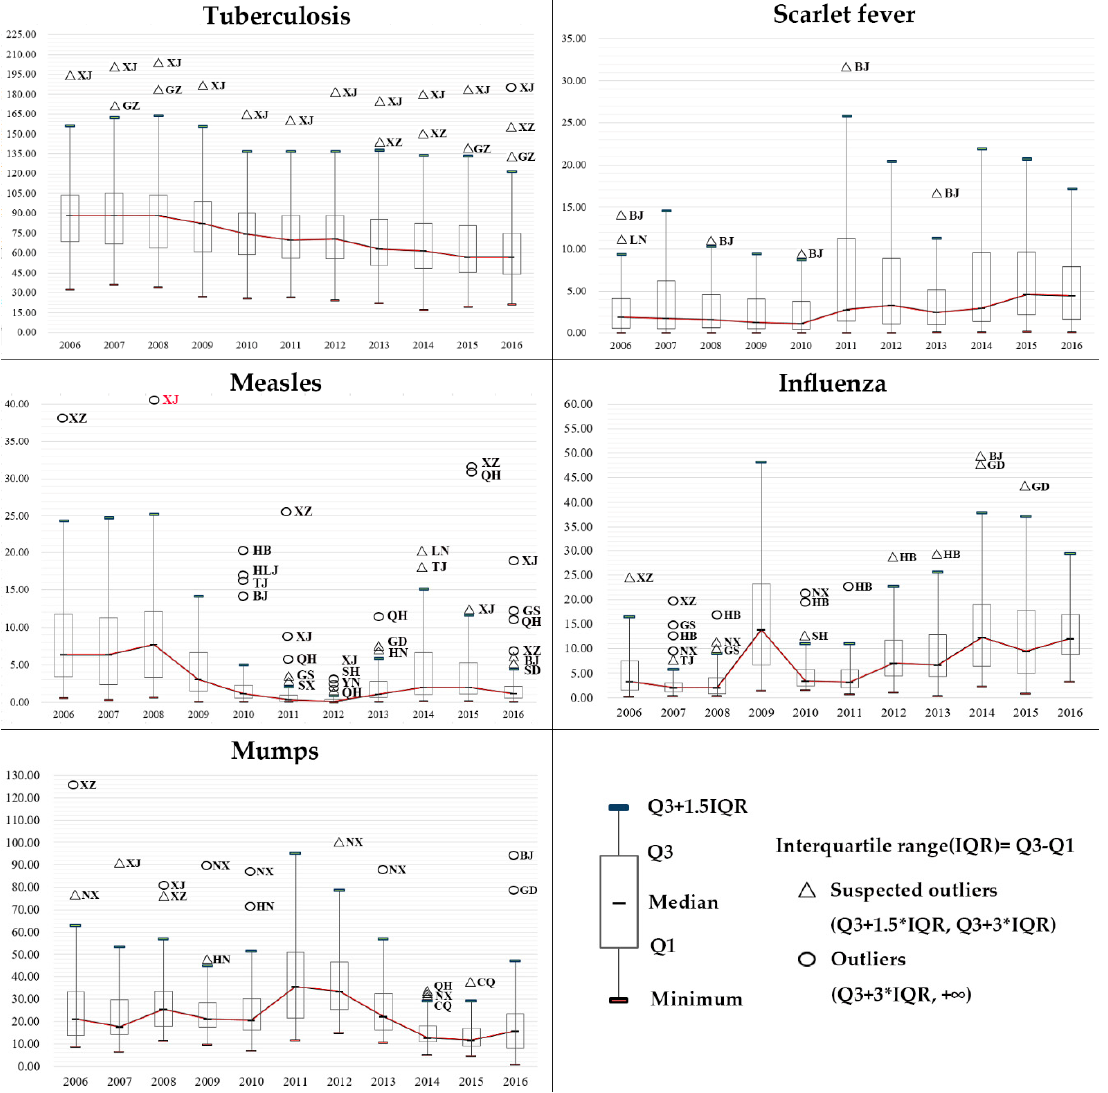
Figure 1. Box plots of the incidence of different types of respiratory infectious diseases (RIDs) (2006–2016).